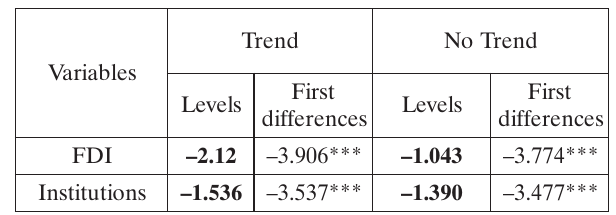
Table 2. IPS Panel unit root